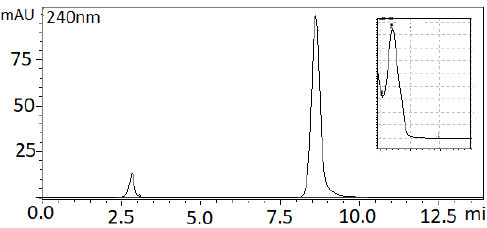
Figure 3. Representative high performance liquid chromatography (HPLC) chromatogram of DSP (30 μg mL −1 ).